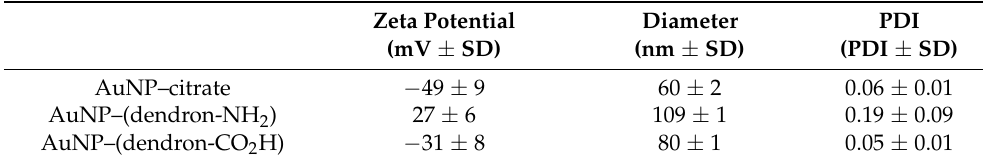
Figure 2. Size distribution profile and the average hydrodynamic diameters obtained by DLS of citrate stabilized AuNPs, cationic dendrimer stabilized AuNPs (AuNP-(dendron-NH 2 )), and anionic dendrimer stabilized AuNP (AuNP-(dendron-CO 2 H)). Table 1. Values of zeta potential, hydrodynamic diameter, and PDI obtained by DLS for the AuNPs measured in ultrapure water at 1